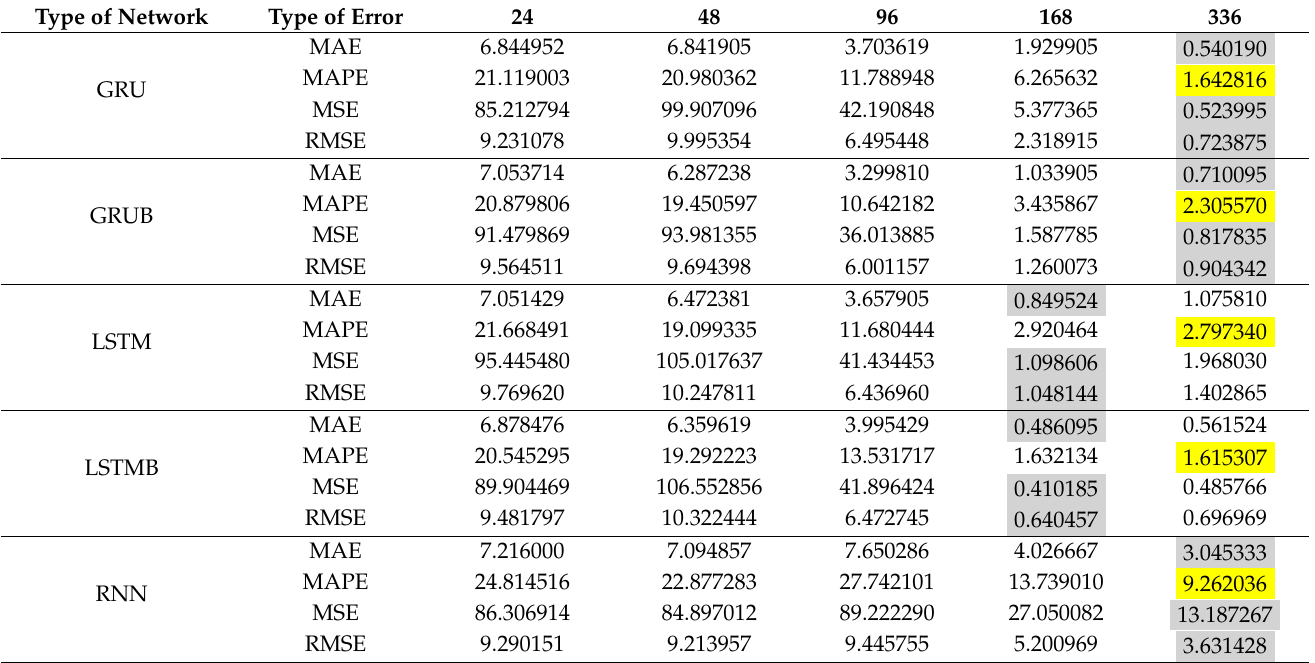
Table 3. Errors for different network structures and different horizons (winter season).